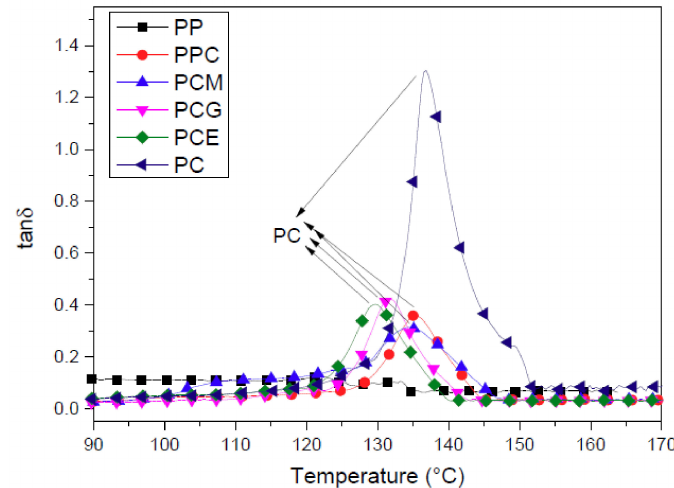
Figure 8. DMA curves (tan δ vs. temperature) of the six foamed PP/PC